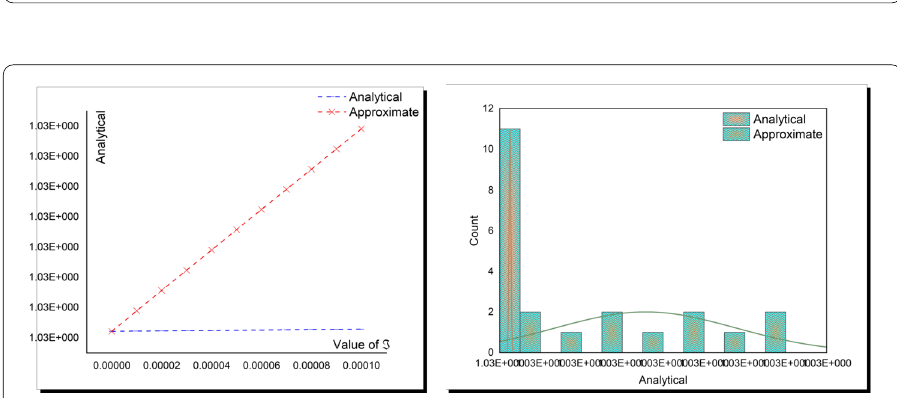
Figure 5 Two-dimensional sketches between the analytical and approximate solutions based on the ExCBS method for illustrating the matching between solutions